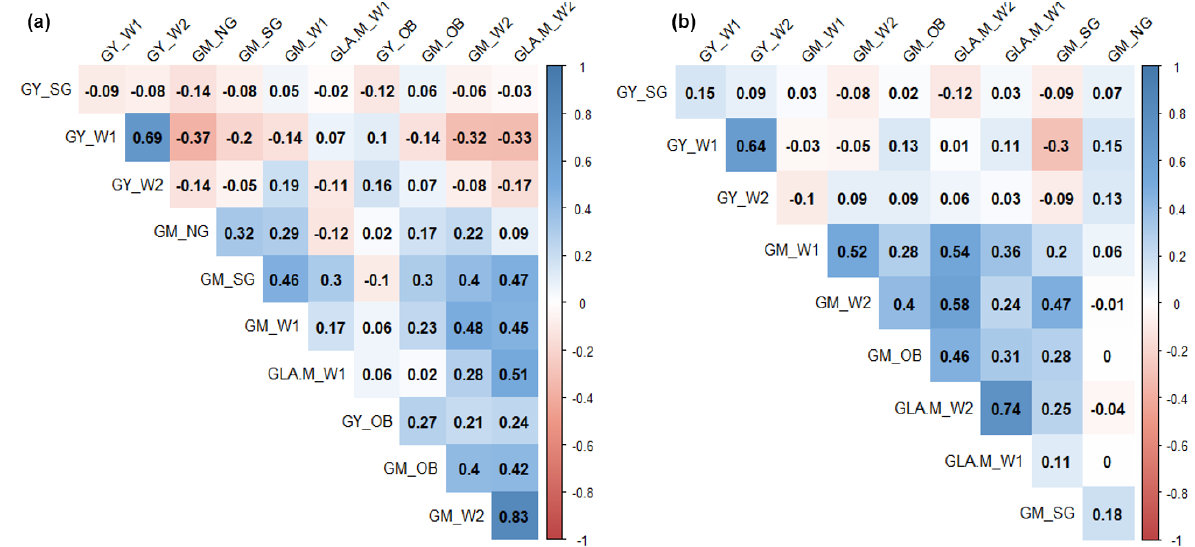
Figure 7. Pearson’s correlation of percentage greenness at maturity (GM), green leaf area at maturity (GLA.M), and grain yield (GY) of the ( a ) 46 and ( b ) 52 stay-green introgression lines and their parents ‘Tabat’ and ‘Wad Ahmed,’ respectively, under irrigated (W1) and drought (W2) at Khartoum North, and rainfed at South Gedaref (SG), North Gedaref (NG) and El Obaied (OB). Absolute values > 0.30 were significant at ( p = 0.05) .